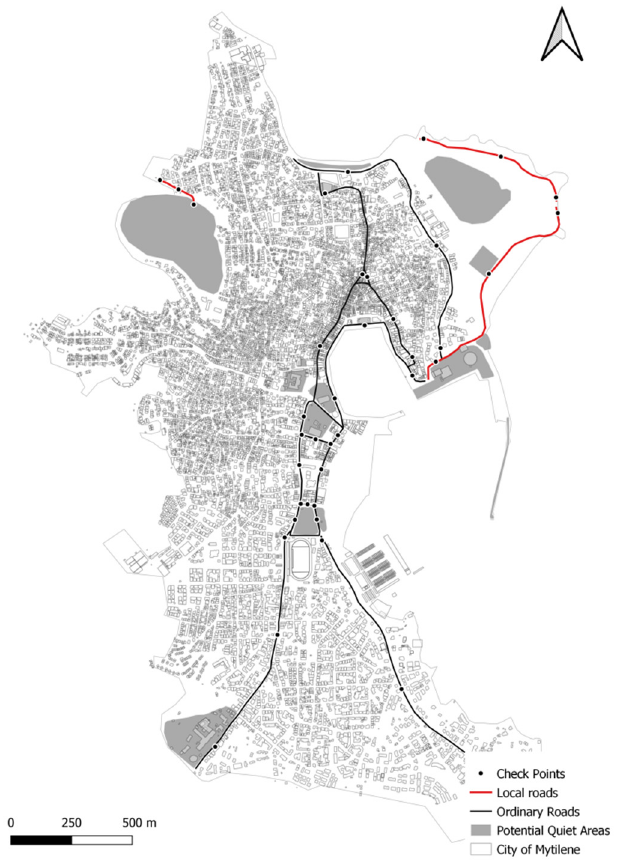
Figure 2. The local and ordinary roads crossing the case study areas and the 39 check points.